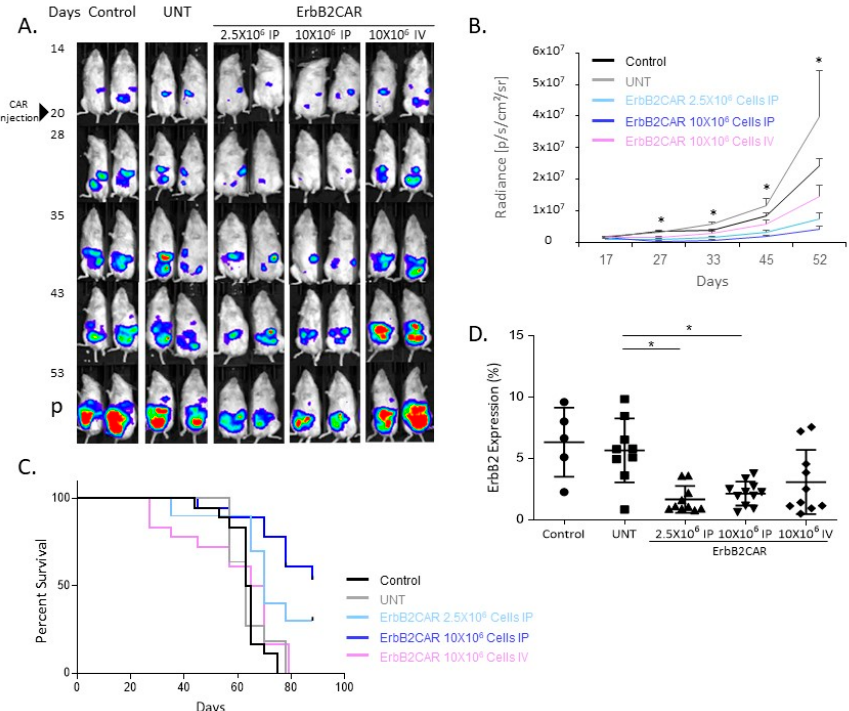
Figure 2. Antitumor effect of ErbB2CAR in an ovarian mouse model. Mice were intraperitoneally engrafted with 2 × 10 6 luciferase-expressing NAR tumor cells (NARLUC). After 20 days, the mice were treated with ErbB2CAR (2.5 × 10 6 IP or 10 × 10 6 IP or 10 × 10 6 IV), with non-infected T cells (UNT), or left untreated (Control). ( A ) Tumor burden assessment of NARLUC in treated mice as imaged by IVIS at the indicated days. The arrowhead indicates CART injection at day 20. ( B ) Summary of averaged radians (p/s/cm 2 /sr) of three in vivo experiments. Each group includes 10–18 mice ± SEM. Data were analyzed by 2-way ANOVA test of ErbB2CAR (2.5 × 10 6 IP or 10 × 10 6 IP) versus UNT * p < 0.01, and 10 × 10 6 IP versus 10 × 10 6 IV * p < 0.05 ErbB2CAR 10 × 10 6 IV versus UNT. ( C ) Kaplan–Meier survival curves of mice in different treatment groups. Each group included 10–18 mice ± SEM. * p < 0.0001 ErbB2CAR 10 × 10 6 IP versus 10 × 10 6 IV and ErbB2CAR 10 × 10 6 IP versus UNT. * p < 0.05 ErbB2CAR 10 × 10 6 IP versus UNT. ErbB2CAR 10 × 10 6 IV versus UNT was not significant. ( D ) The mice were euthanized 45 days post-NAR-LUC injection. Cells from ovaries were isolated, stained with anti-human ErbB2-APC, and analyzed by flow cytometry. Each group includes an average of 5–11 mice ± SEM. Data were analyzed by 1-way ANOVA test * p <